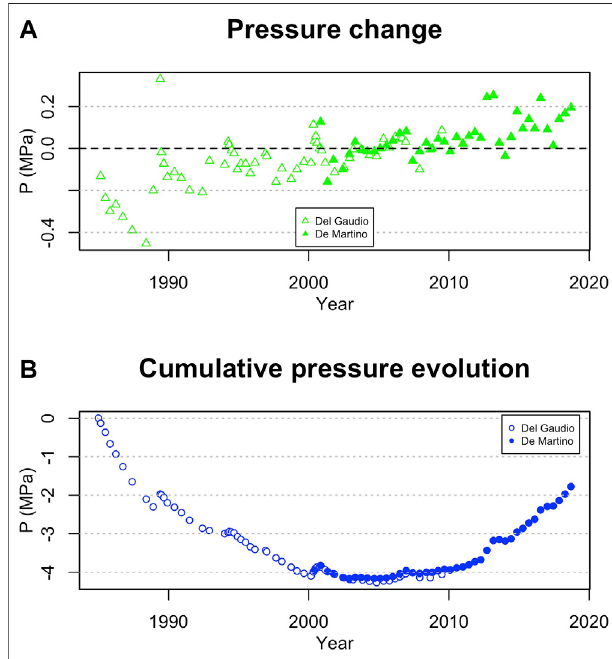
FIGURE 5 | (A) Pore pressure changes (green) calculated from post- 1985 displacement data, assuming the system geometry shown in Figure 4 and (B) the corresponding pressure evolution (blue). Open symbols refer to thedatasetbyDelGaudioetal.(2010),whilesolidsymbolsarebasedon data by De Martino et al.